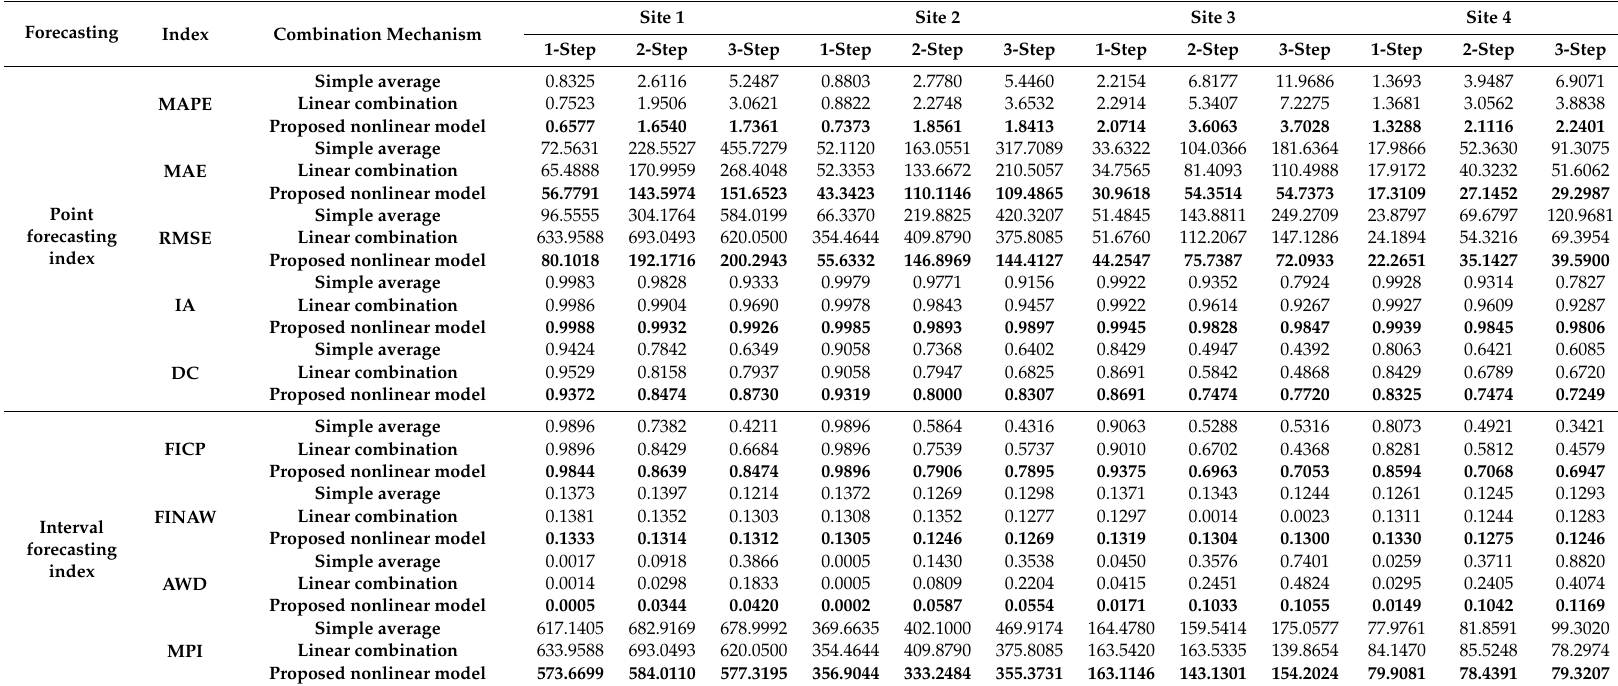
Table 13. Three di ff erent combination